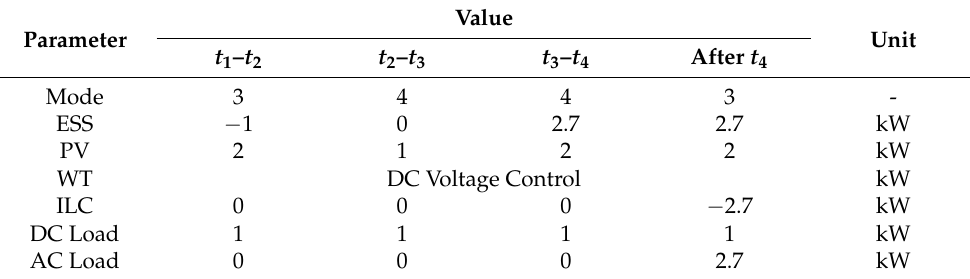
Table 6. Microgrid power flow (2) during standalone operation.